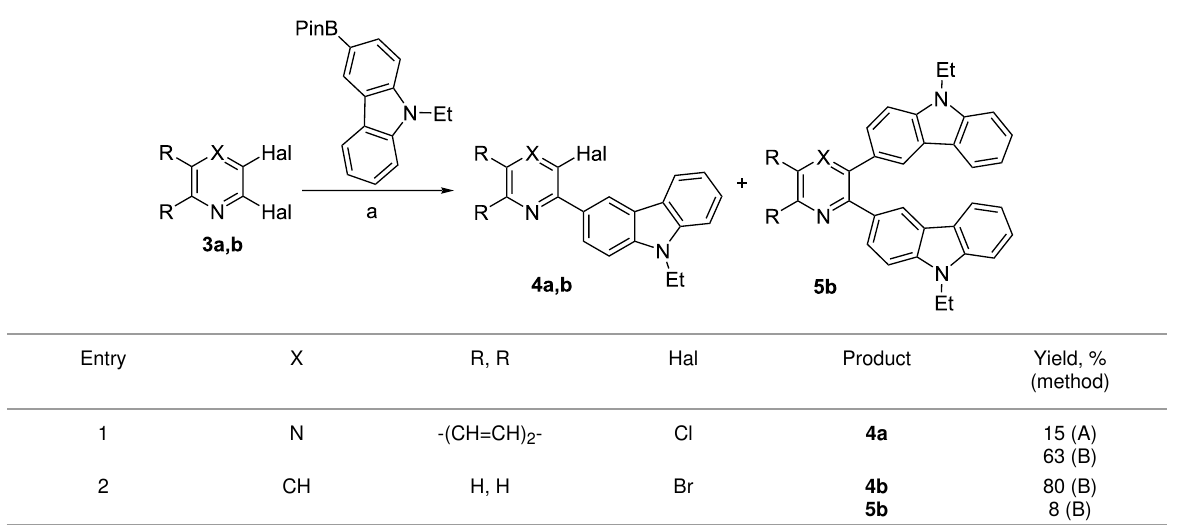
Table 2: Suzuki coupling of compounds 3 with 9-ethyl-3-(4,4,5,5-tetramethyl-1,3,2-dioxaborolan-2-yl)-9 H -carbazole.